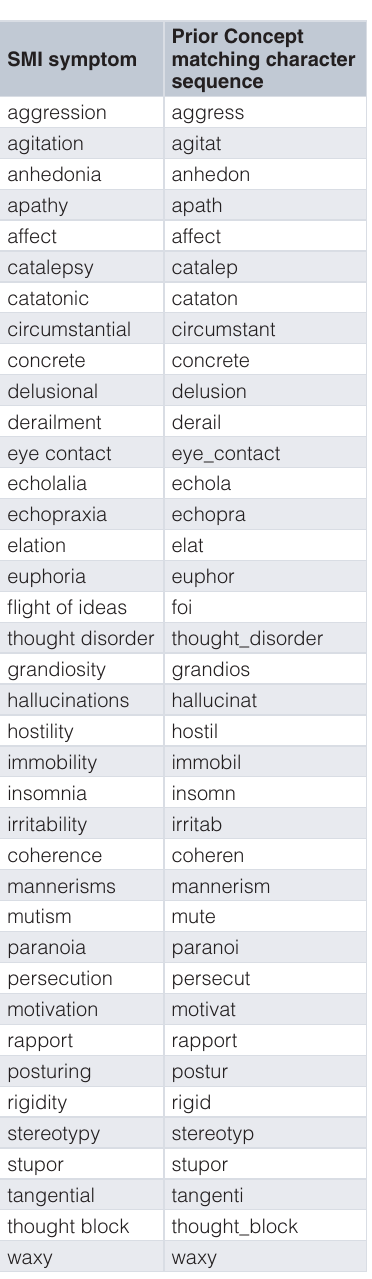
Table 1. Known symptomatology concepts and Prior Concept vocabulary matching sequences used for cluster scoring. An underscore represents a bigram